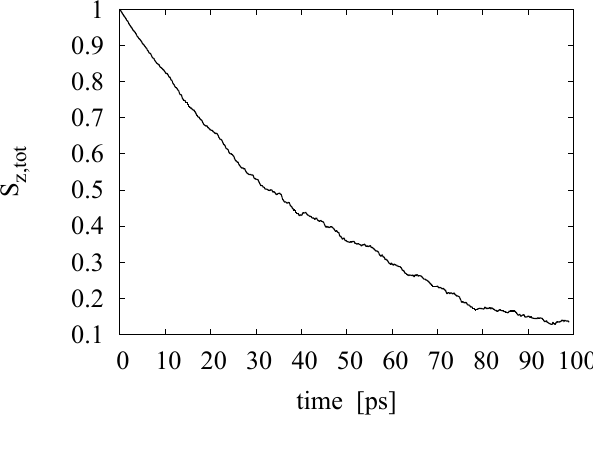
= 10 16 cm − 3 at T = 300 e